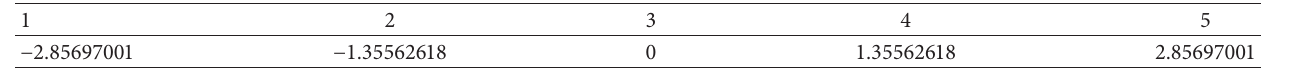
Table 2: Estimating points in the standardized normal space.